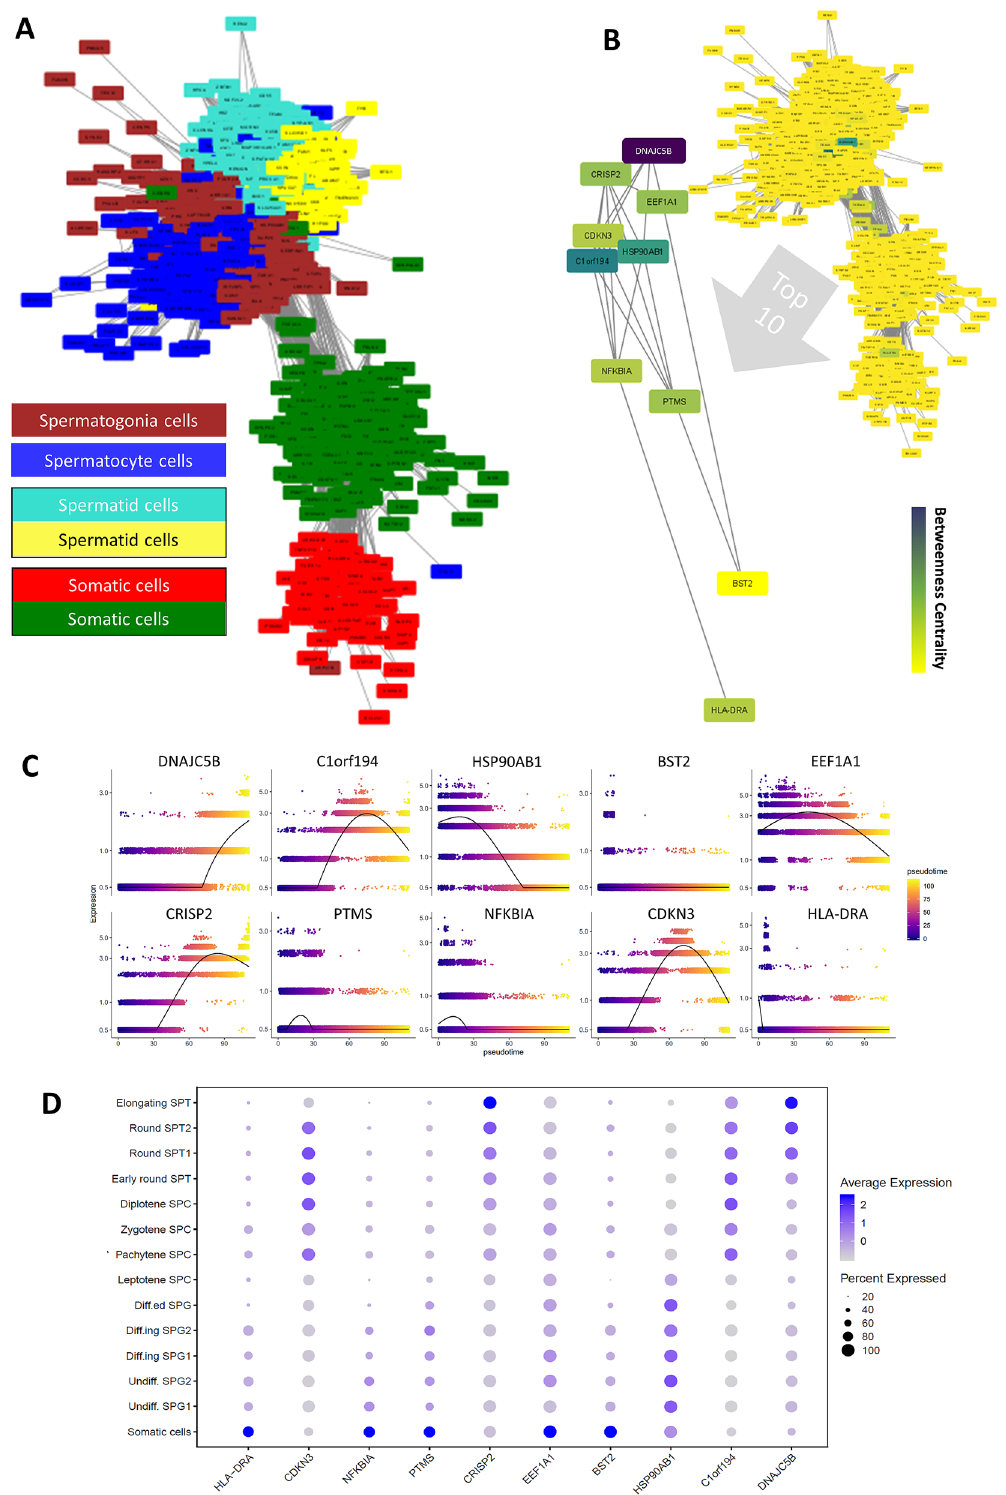
Figure 5. Betweenness centrality analysis of the weighted gene co-expression network. ( A ) The presentation of the weighted gene co-expression network. The relation between colored modules and cell types were shown in the inset figure. ( B ) The co-expression network was colored based on the betweenness centralities from yellow to purple. The top ten genes with the highest betweenness centralities are highlighted. ( C , D ) The expressions of these top betweenness centrality genes along ( C ) the pseudotime and ( D ) the cell-types